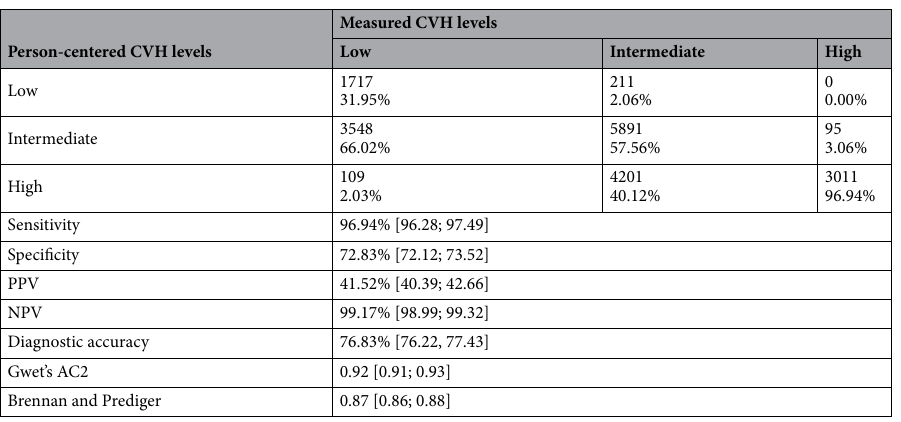
Table 3. Validity of person-centered and measured ideal cardiovascular health (CVH). CVH cardiovascular health, LS7 life’s simple 7, PPV positive predictive value, NPV negative predictive value. Low, intermediate, and high CVH correspond to 0–2, 3–4, and 5–7 ideal LS7 metrics, respectively. Sensitivity, Specificity, PPV, and NPV Statistics were computed for ideal and non-ideal categories of person-centered and measured CVH. Diagnostic accuracy was calculated using the proportion of a true ideal and true non-ideal measured classification according to the person-centered CVH among all the participants. Weighted Gwet’s AC2/ Brennan and Prediger statistics evaluated the concordance between the person-centered and measured number of ideal LS7